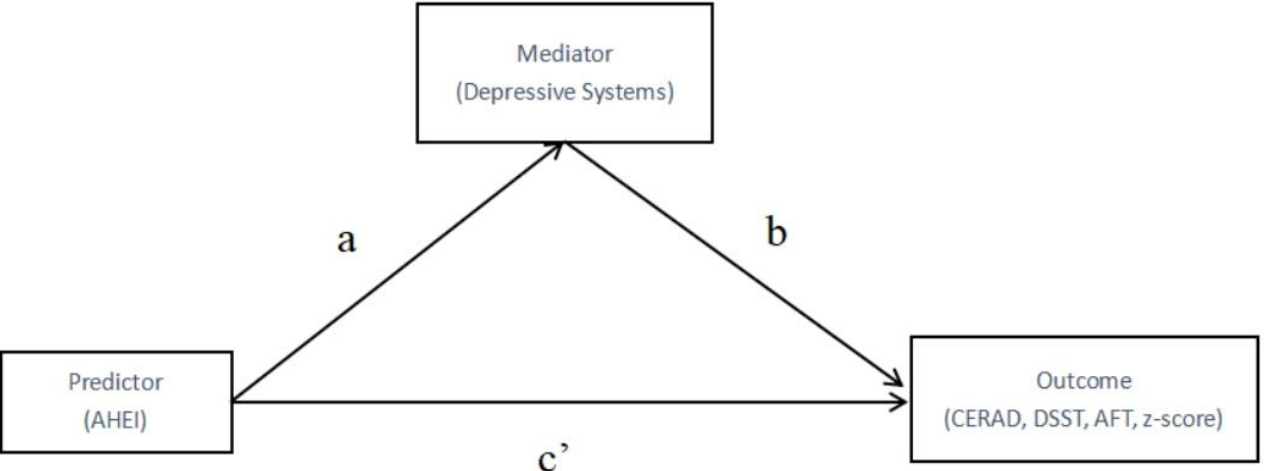
Figure 2. Path diagram of mediation model. ( a ): the effect of AHEI on the depressive systems; ( b ): the effect of depressive systems on cognitive function (CERAD, DSST, AFT, z-score); ( c’ ): the direct effect of predictor on cognitive function (CERAD, DSST, AFT,